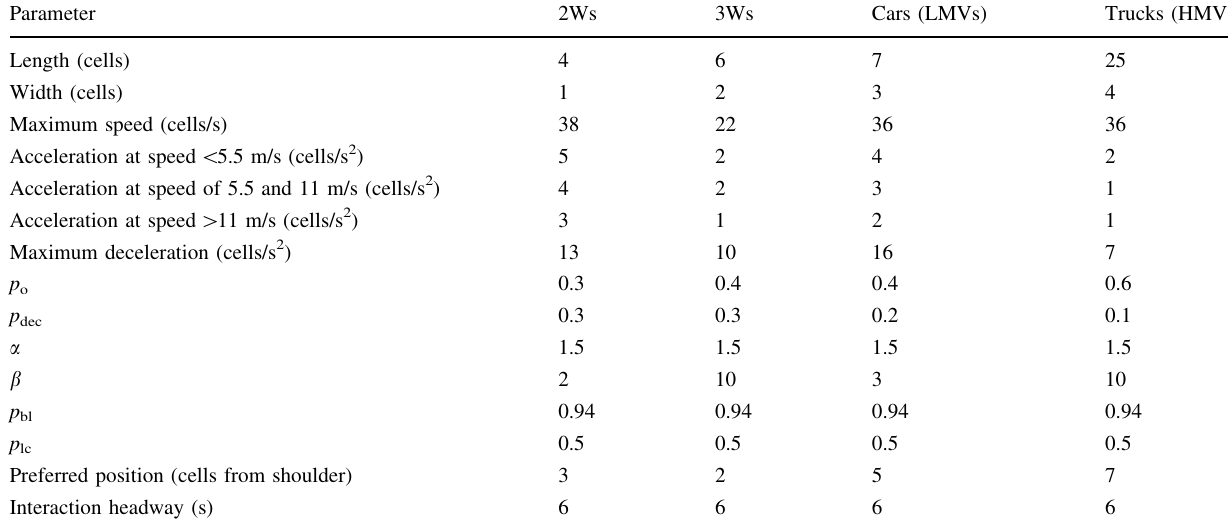
Table 1 Values of the parameters used in simulation